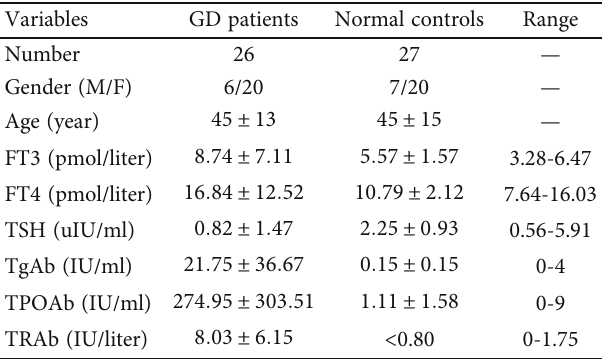
Table 1: Clinical characteristics of GD patients and normal